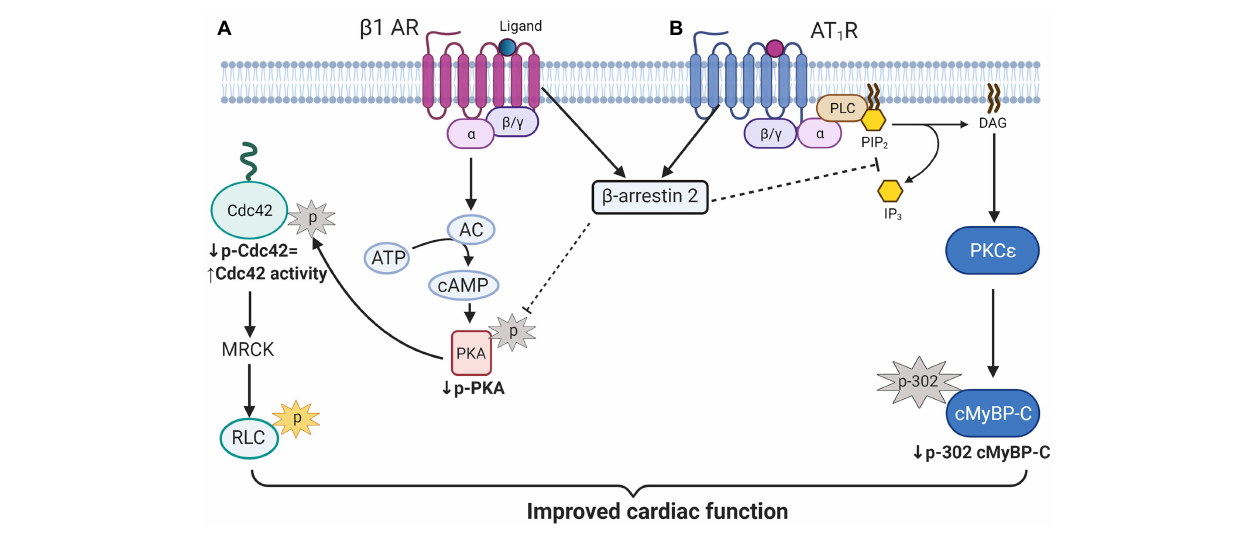
FIGURE 7 | Scheme illustration of proposed β -arrestin-2 signaling in cardiomyocytes. (A) β -arrestin-2 signaling inhibits PKA activation by phosphorylation. Decreased PKA activity results in decreased Cdc42 phosphorylation that promotes its activation. Active Cdc42 may promote RLC phosphorylation through myotonic dystrophy-related Cdc42-binding kinase (MRCK) activation to preserve contractile function in aged mice. ( B) β -arrestin-2 also inhibits phospholipase C (activated by AT1R signaling) resulting in the inhibition of PKC signaling. Inhibition of PKC activity results in decreased cMyBP-C phosphorylation at Ser302 that ɛ ɛ may prevent the heart from failing. AC, adenylate cyclase; MRCK, myotonic dystrophy-related Cdc42-binding kinase; RLC, regulatory light chain; PLC, phospholipase C; PIP2, Phosphatidylinositol 4, 5-bisphosphate; IP3, inositol triphosphate; DAG, diacylglycerol; and cMyBP-C, cardiac myosin binding protein-C. Created with